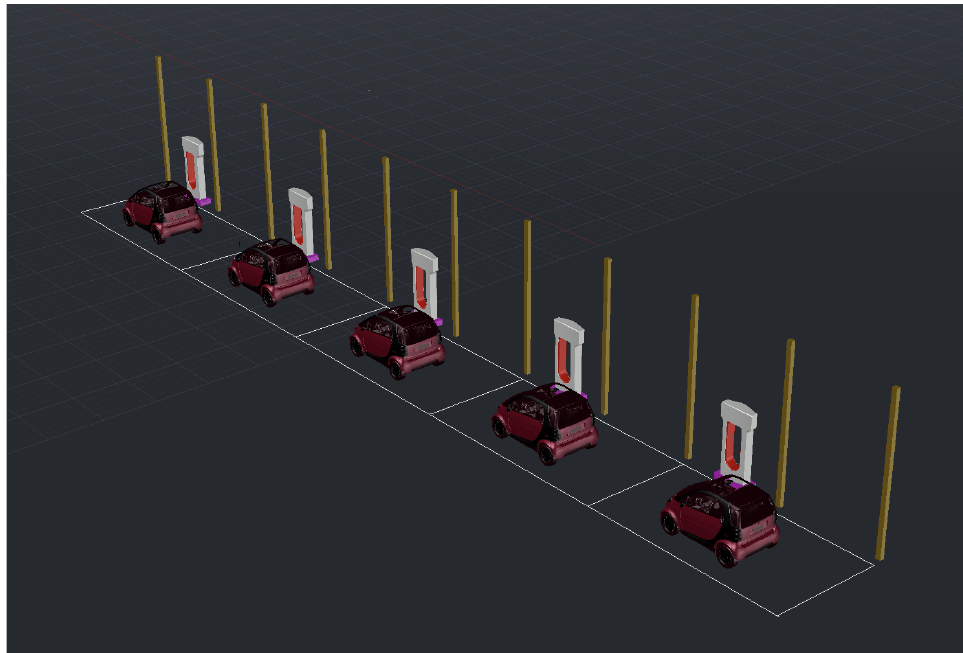
Figure 8. Post arrangement for the cantilevered system.